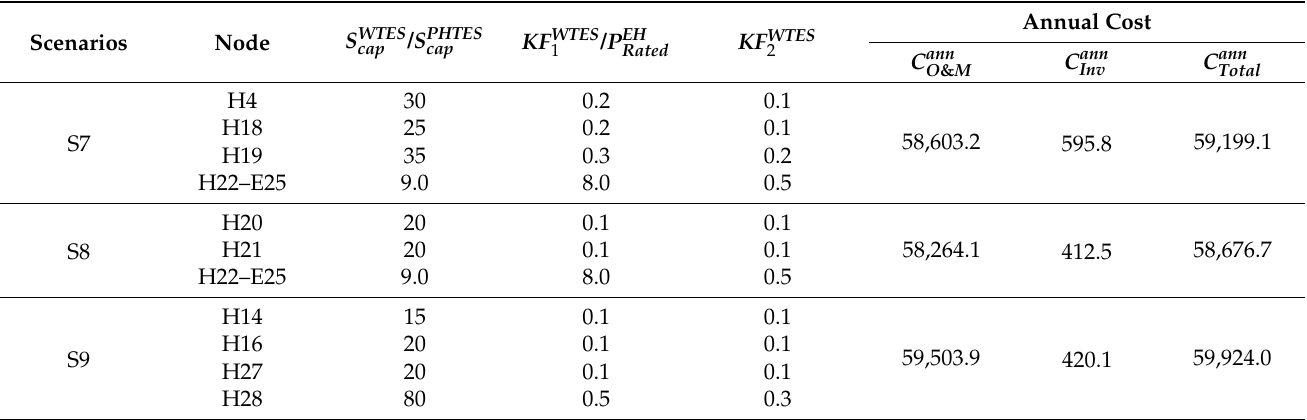
Table 7. Optimization results of configuration schemes of